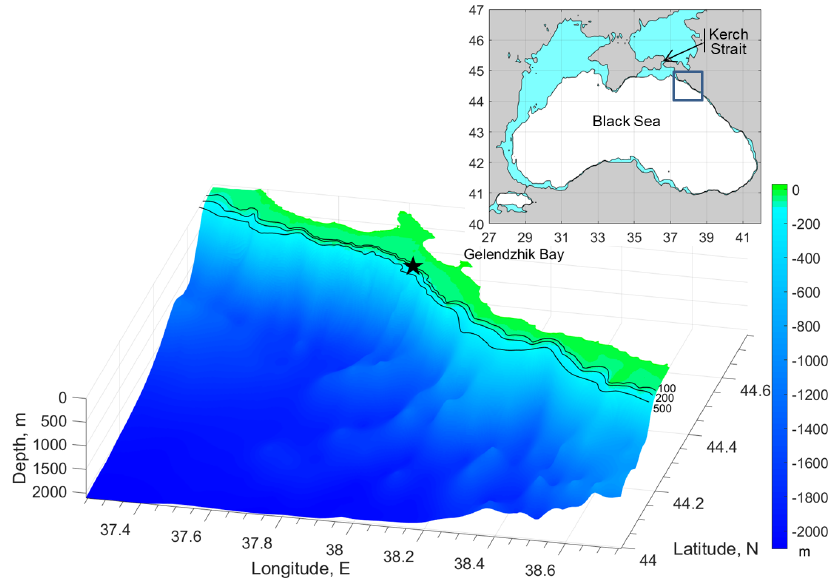
Figure 1. Bottom topography of the NE Black Sea (based on European Marine Observation and Data Network bathymetry; http://www. emodnet-hydrography.eu/, last access: 21 October 2018). The black star indicates the location of the Aqualog profiler mooring. Notice the narrow (width of only a few kilometers) and shallow (depth less than 100m) sea